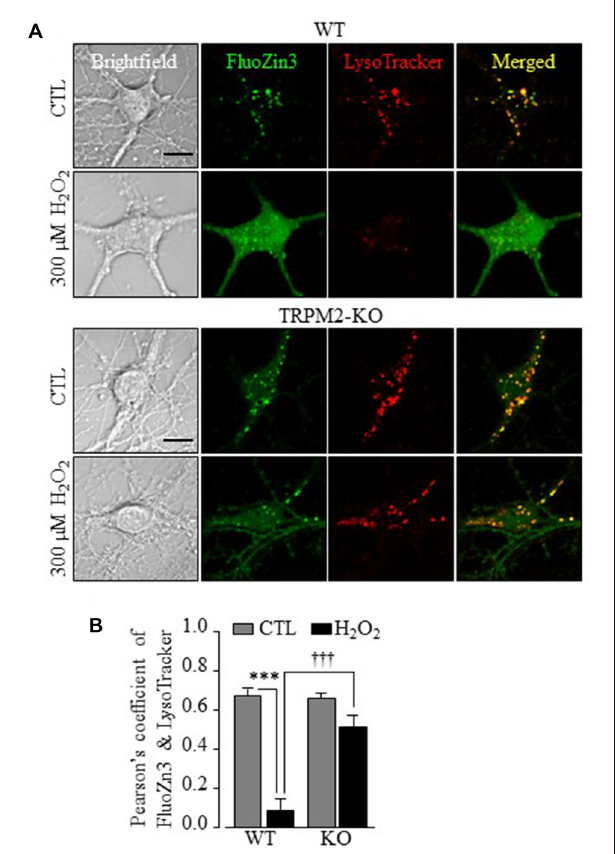
FIGURE 3 | TRPM2 is required in H 2 O 2 -induced lysosomal dysfunction, cytosolic Zn 2 + increase in hippocampal neurons. (A) Representative confocal images showing FluoZin3 (green) and LysoTracker (red) in WT or TRPM2-KO neurons under control (CTL) or treatment with 300 µ M H 2 O 2 for 30 min. Scale bar is 10 µ m. (B) Mean Pearson’s correlation coefficient from three independent experiments with each experiment analyzing 12–18 neurons. ∗∗∗ p < 0.005 indicates difference from control and ††† p < 0.005 indicates difference between WT and TRPM2-KO neurons treated with H 2 O 2